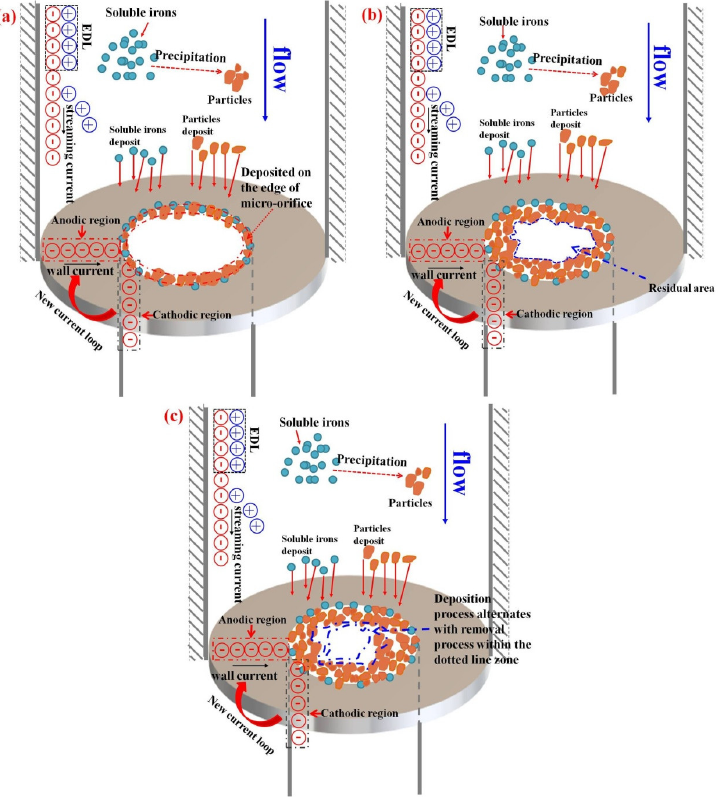
Figure 11. Schematic of the growth process of the clogging behavior formed on 304 SS disc with a micro-orifice of 300 µ m in diameter drilled in the center. ( a ) Ionic dissolution stage. ( b ) stable deposition stage ( c ) dynamic equilibrium